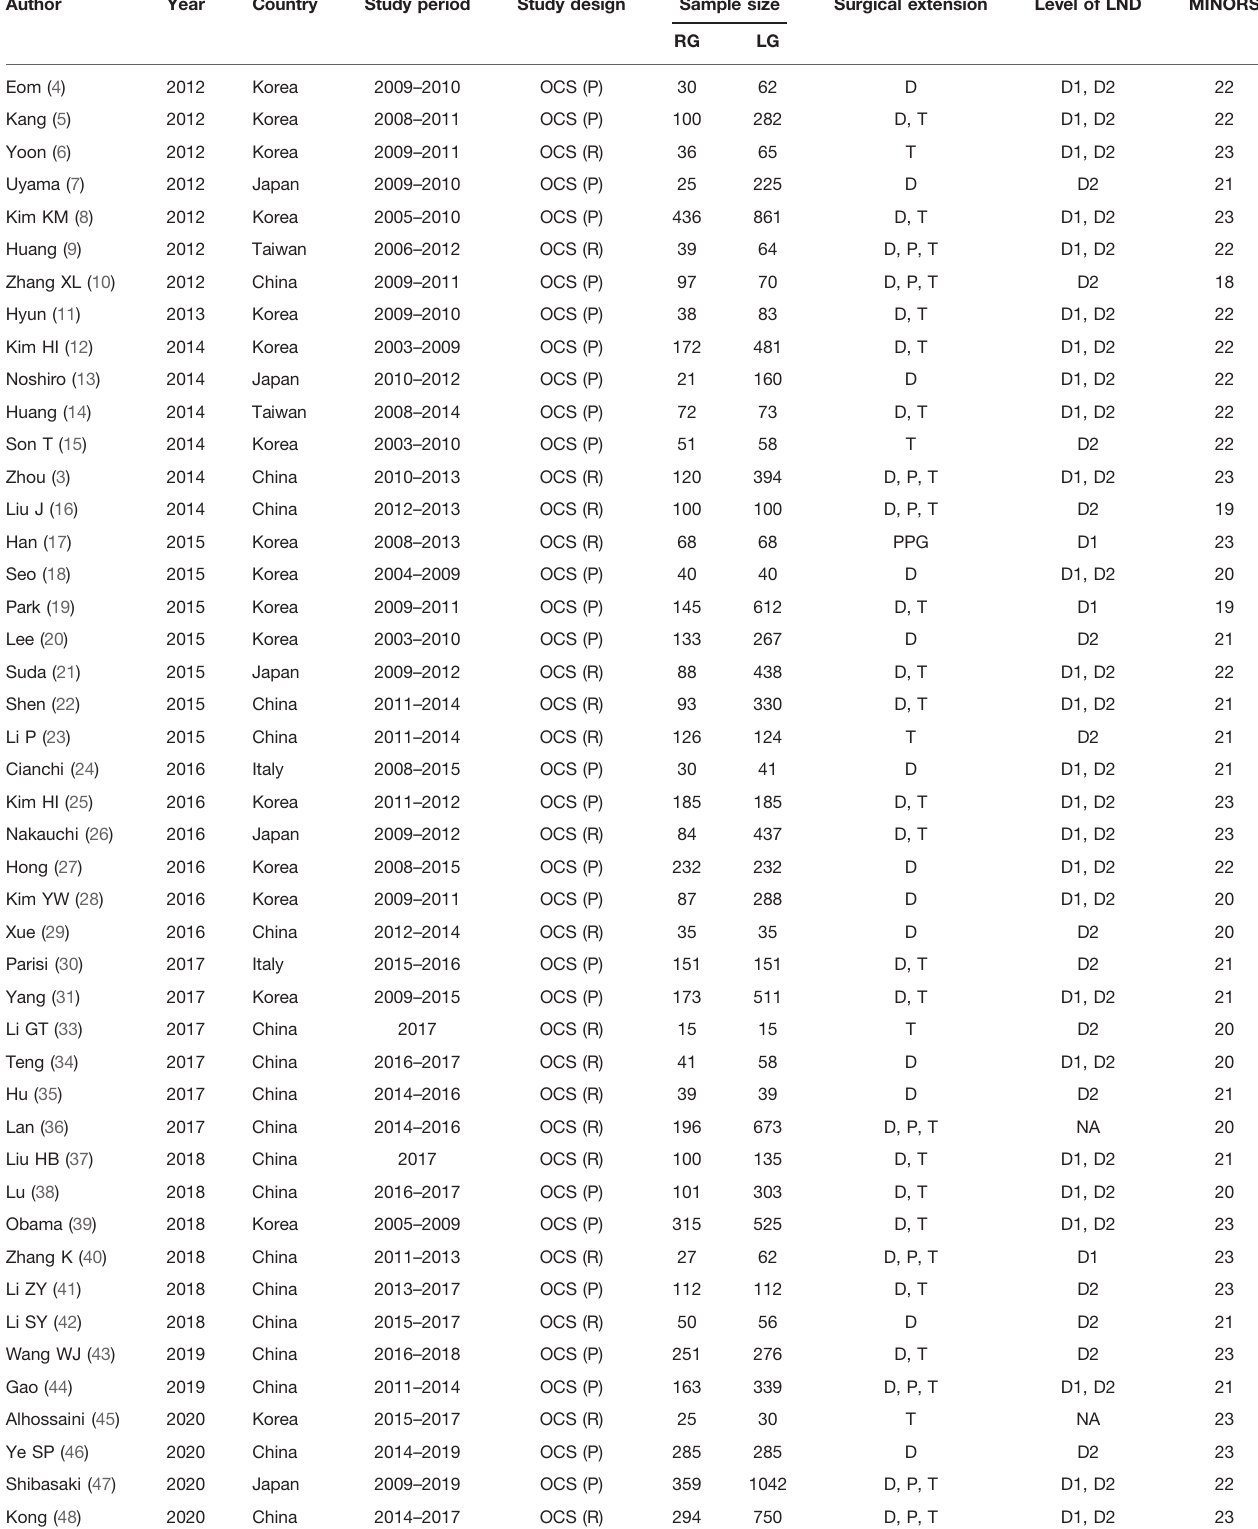
TABLE 1 | Basic characteristics of the literatures included in the